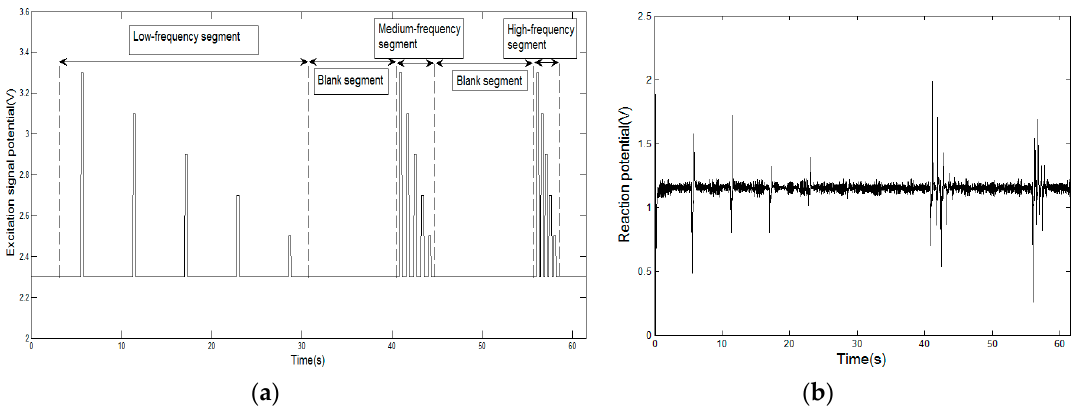
Figure 2. ( a ) Excitation signal of multiple LAPV (MLAPV). ( b ) Typical response of a working